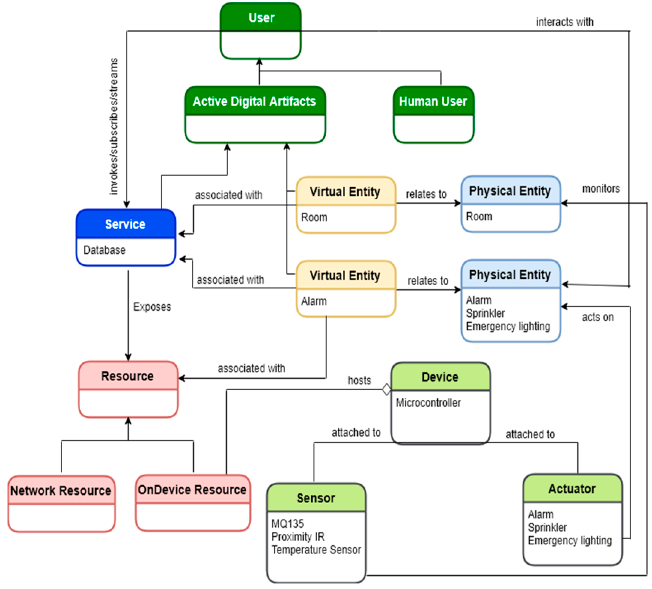
Figure 6. Proposed UML representation of the IoT Domain Model.